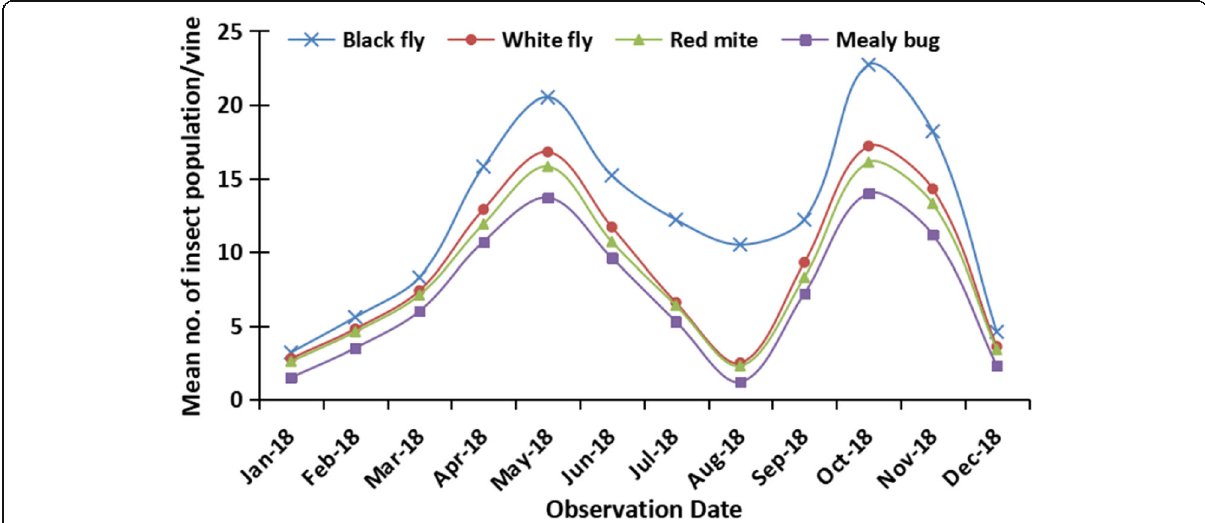
Fig. 1 Mean number of insect population per vine observed at different date in Betel leaf. It was evident from the study that black fly population incidence was started from the month of January (3.2 adult/vine) and continued until the entire growing period of the crop. Population ranged from 3.2 to 22.7 and reached its peak 20.5/vine and 22.7/vine during the month of May and October,